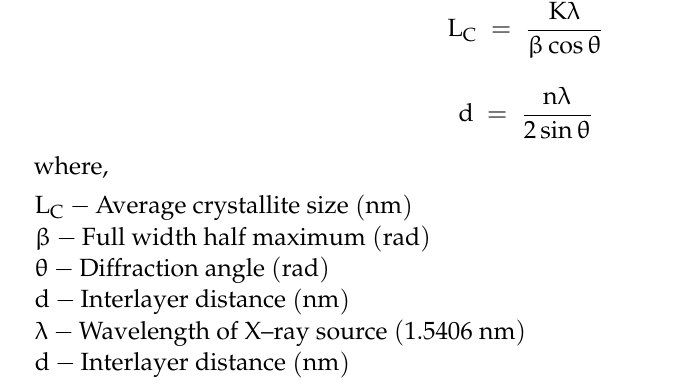
Table 3. Structural properties of the composite analyzed by XRD crystalline